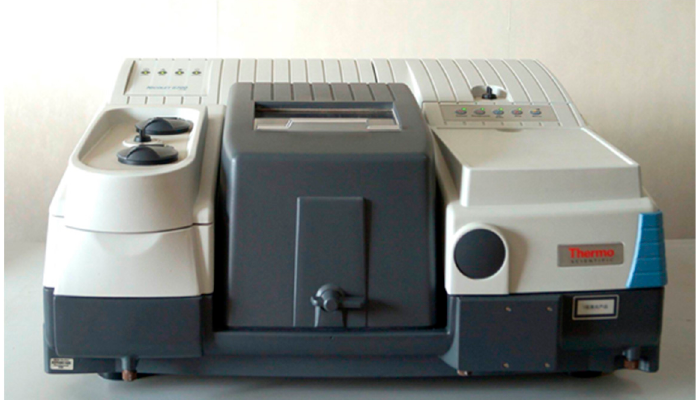
Figure 4. Photograph of the FTIR used in this work.